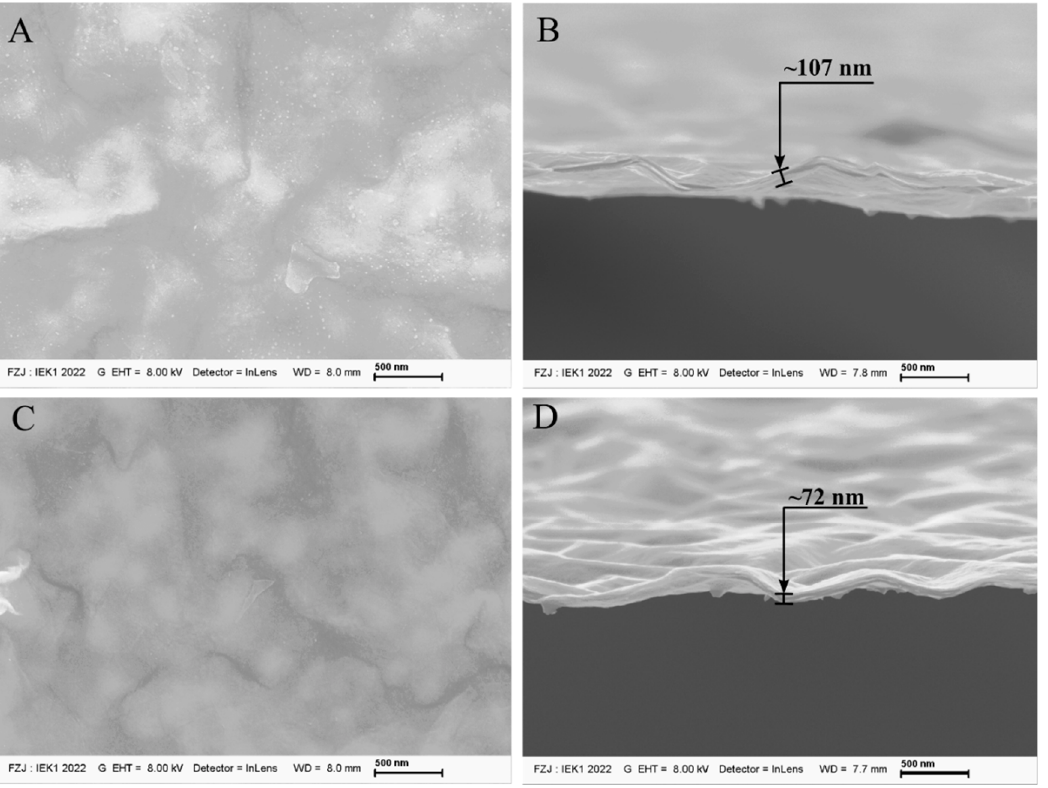
Figure 5. ( A – D ): SEM images of Ti 3 C 2 MXene membranes produced via dip coating on an α -Al 2 O 3 substrate from suspensions C 1 treated at 80 °C and 500 °C under H 2 /Ar atmosphere, respectively.